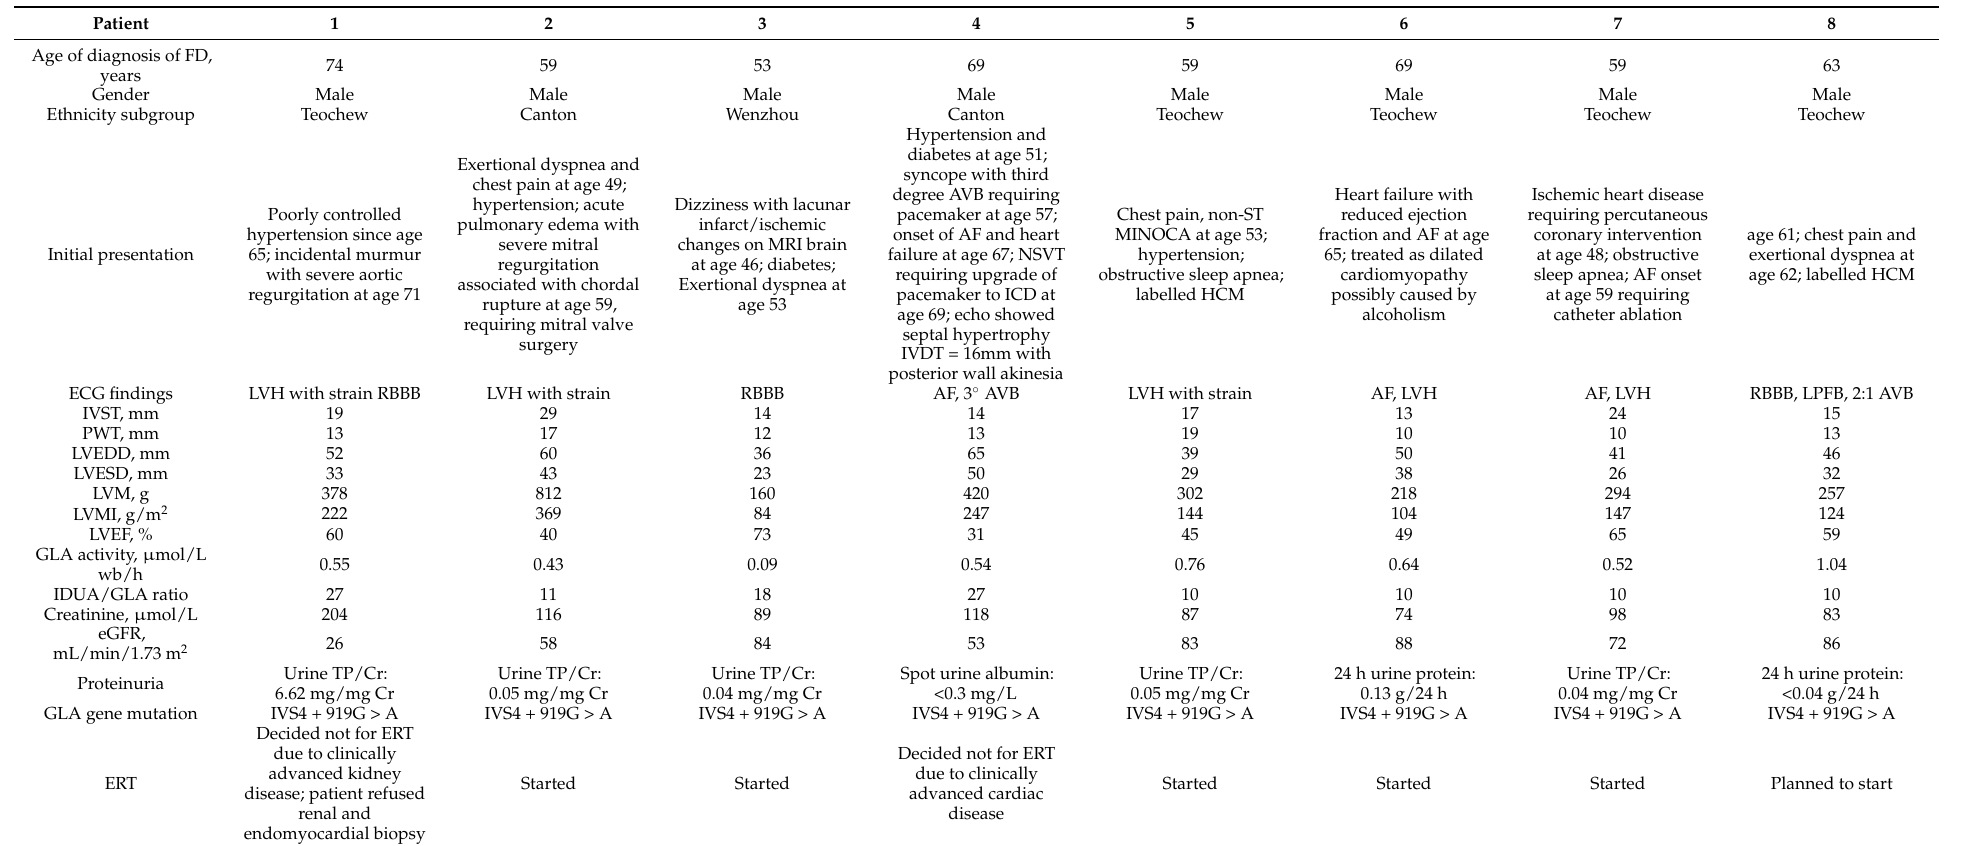
Table 2. Characteristics of patients with confirmed